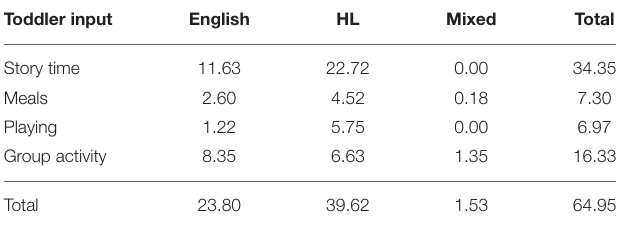
TABLE 4A | Input to toddler group in minutes.